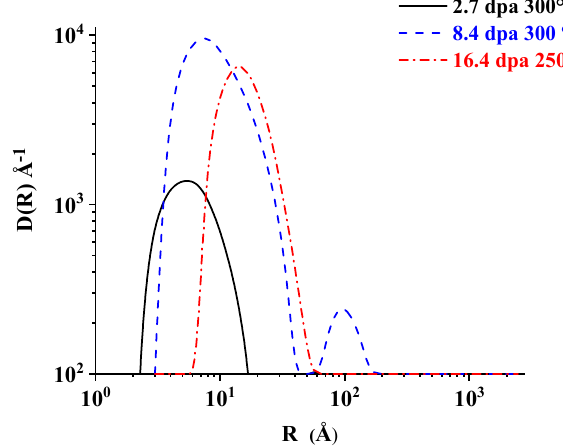
Figure 9. Best-fit micro-voids volume distributions for Eurofer97 neutron irradiated to 2.7 dpa at 300 °C (continuous line), 8.4 dpa at 300 °C (dashed line), 16.3 dpa at 250 °C (dash-dotted line). The distributions are those shown in Figures 6b, 7b, and 8b, respectively after reference sample subtraction. Table 1. Micro-voids volume fractions and average radii in neutron irradiated Eurofer97; the values obtained after subtracting the un-irradiated reference sample’s cross-section are marked in parenthesis and italics.